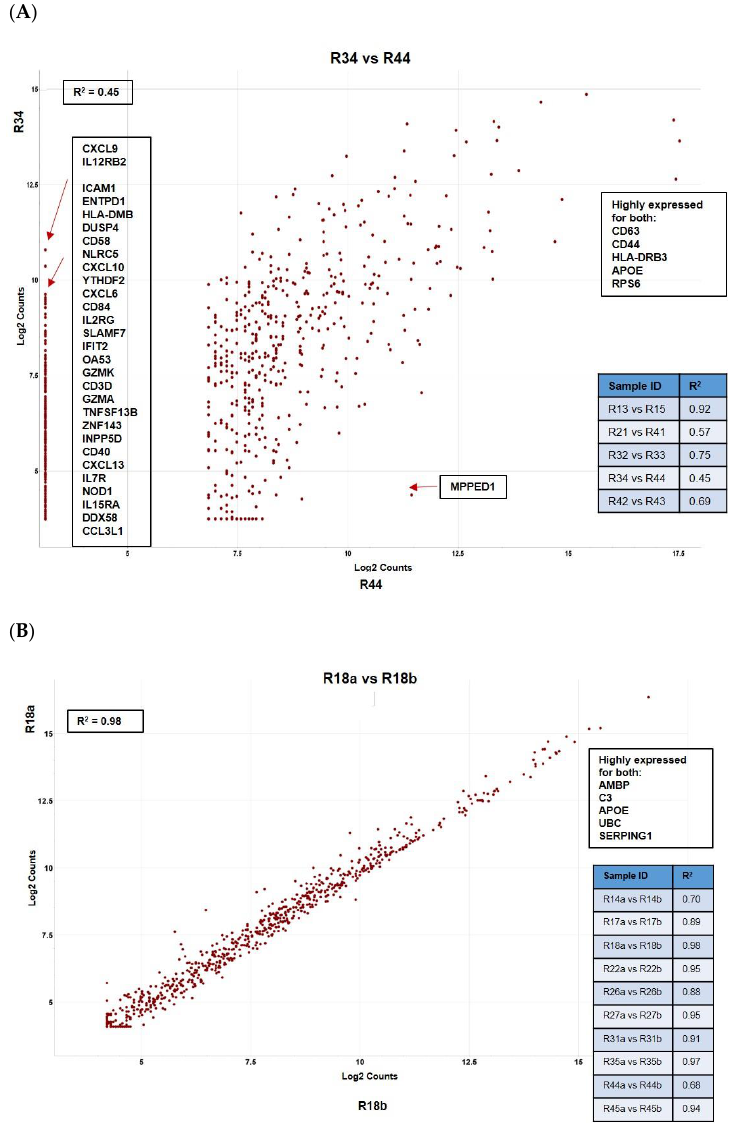
Figure 4. Pairwise ratio comparisons of normalized data demonstrating: ( A ) intersegmental heterogeneity for hepatic mUM taken from the same patient where marked difference in a number of immune-related genes was noted and ( B ) between two histomorphologically distinct areas within the same tumour deposit (intratumoural analysis) showing lack of transcriptomic variability. All results are presented as scattered plots with the “R 2 ” coefficients given for each of the comparisons. Genes consistently highly expressed between samples are highlighted.